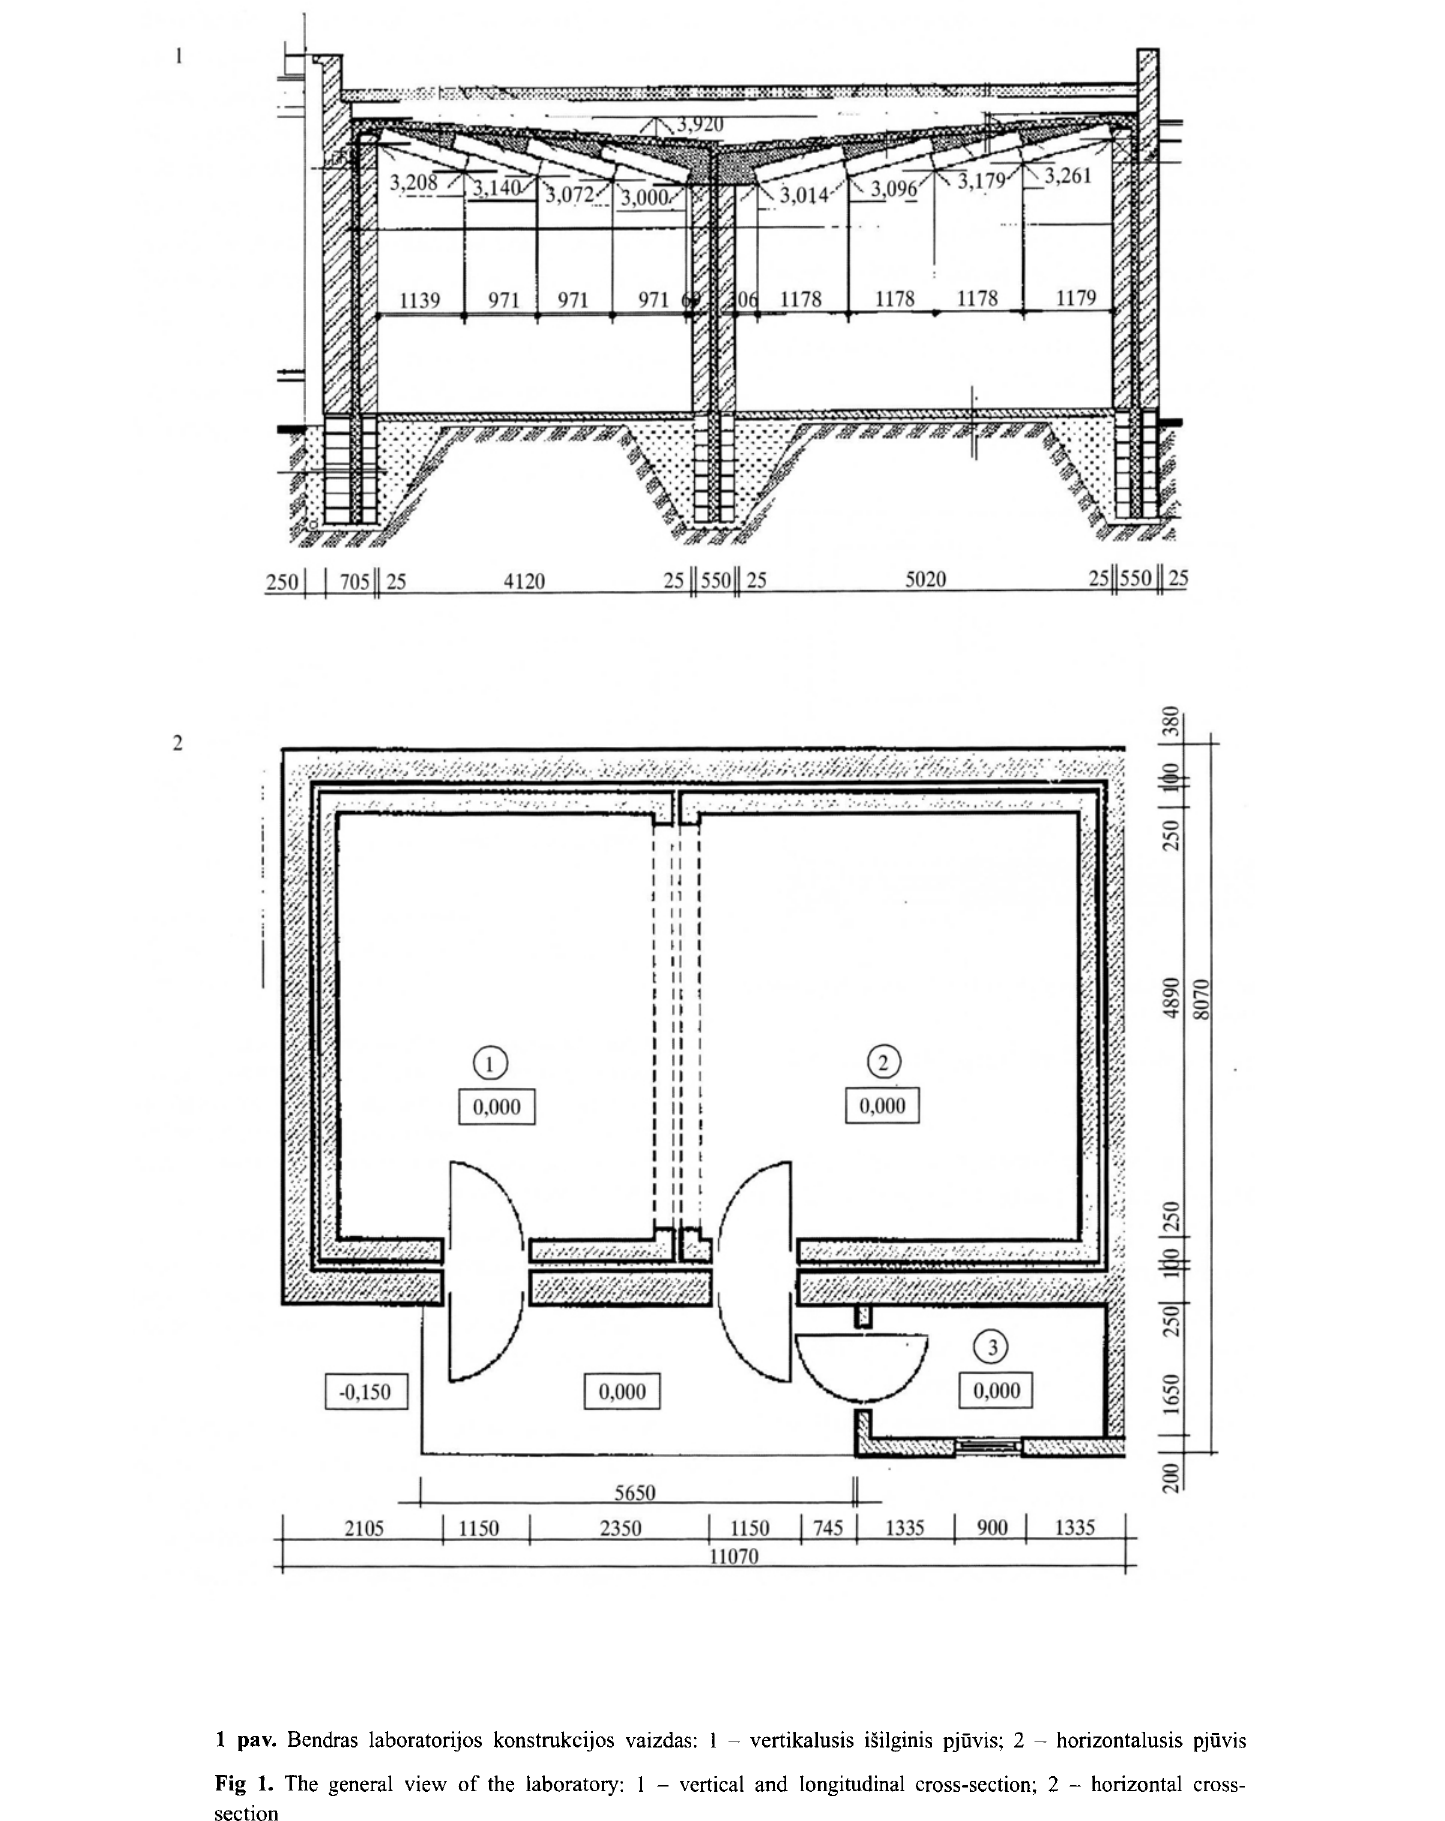
Fig 1. The general view of the laboratm:y: I - vertical and longitudinal cross-section; 2 - horizontal cross